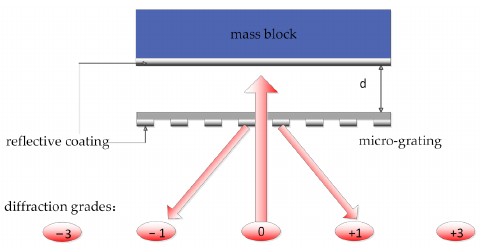
Figure 4. Schematic diagram of the optical displacement readout based on an interferometry cavity. d refers the distance between mass block and the